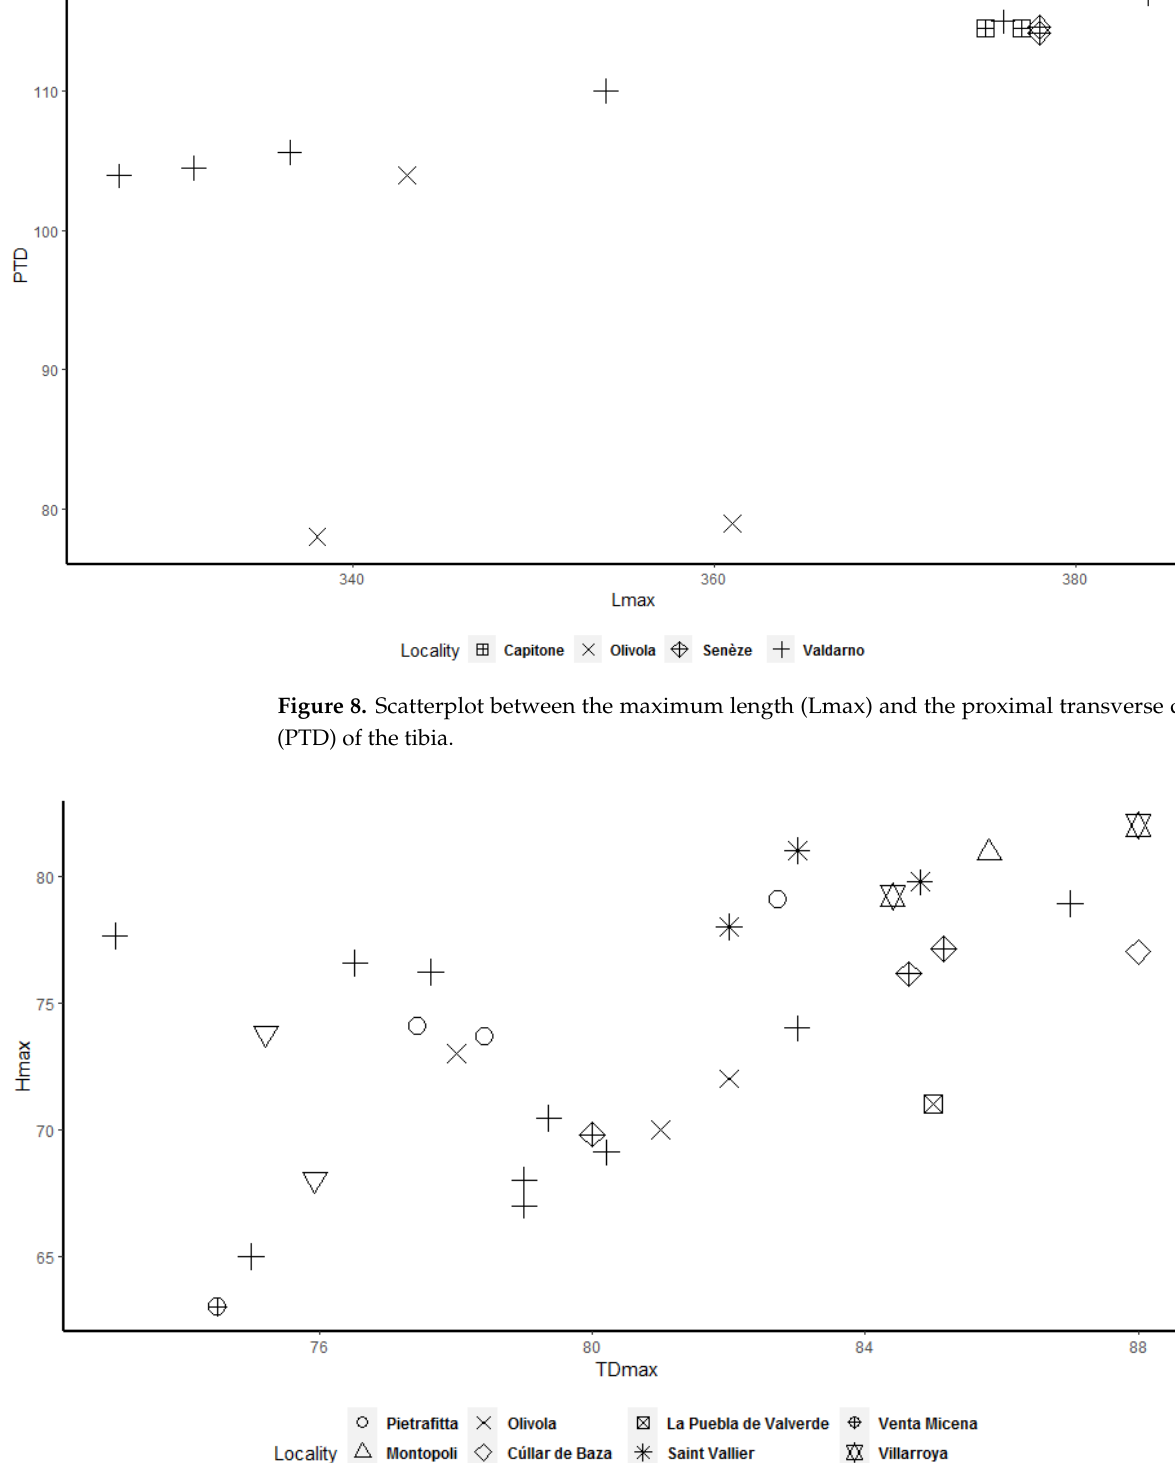
Figure 9. Scatterplot between the maximum transverse diameter (Tdmax) and the maximum height (Hmax) of astragalus.